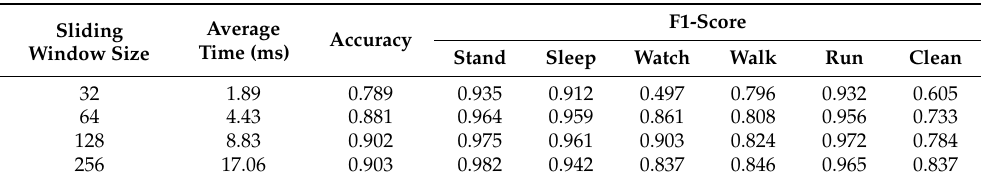
Table 2. Parameter sensitivity analysis of different sliding